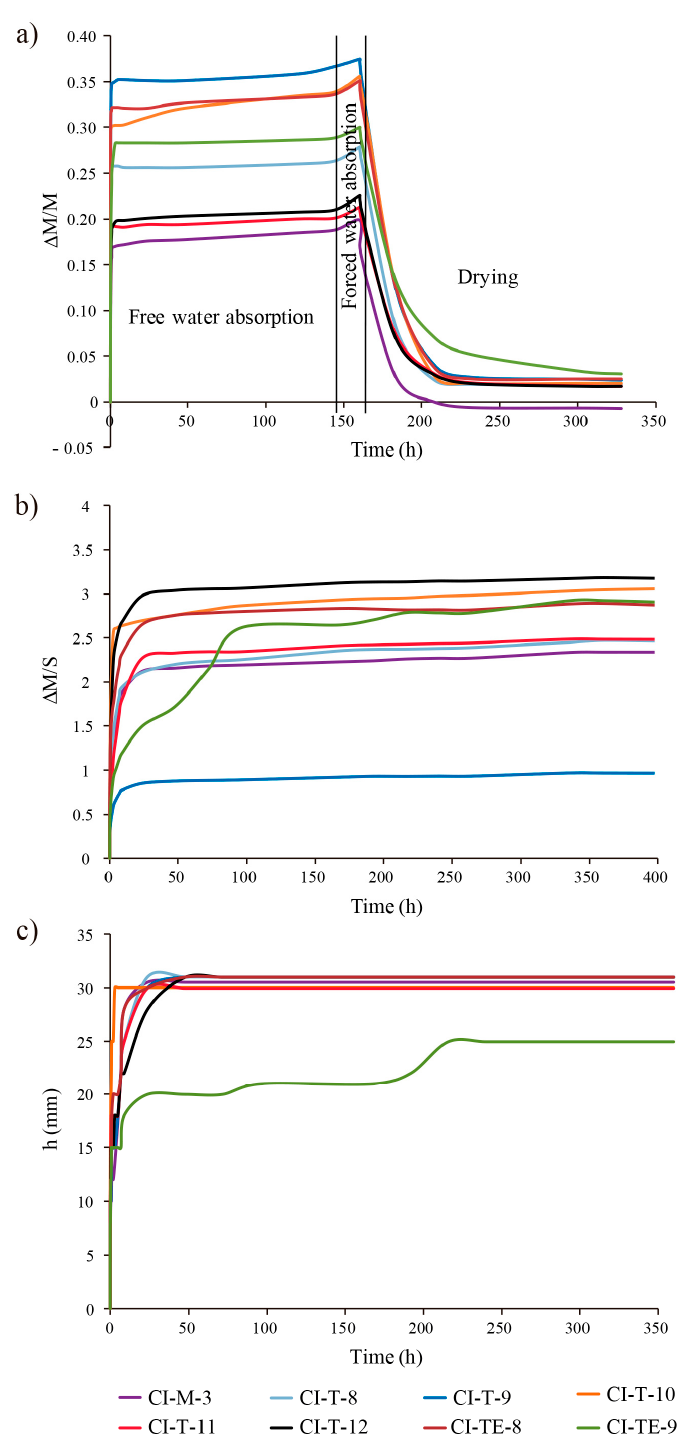
Figure 6. Hydric behaviours of Irulegi Castle lime mortars. ( a ) Free water absorption, forced water absorption and drying curves. Weight variation ( Δ M/M) versus time (in hours). ( b ) Capillary uptake curves: Weight variation ( Δ M/S) versus time (in hours) and ( c ) capillarity front curves. Height (in mm) versus time (in hours).